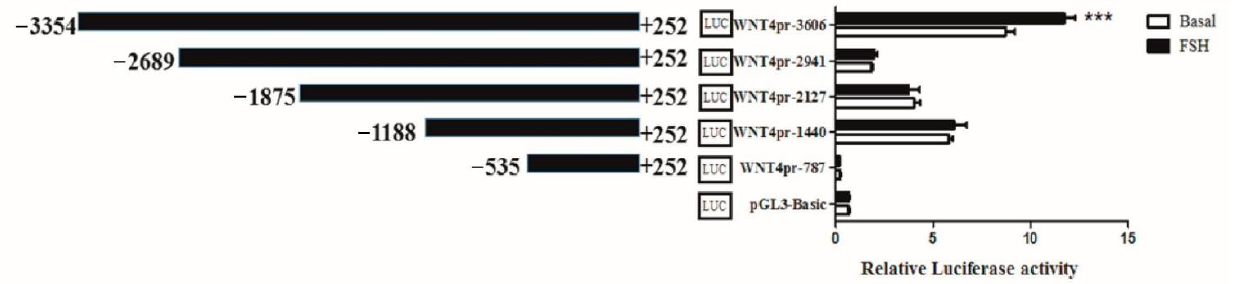
Figure 1. Luciferase assay of the effects of FSH on WNT4 promoter activity in chicken GCs. The numbering refers to the transcription initiation site, designated as +1. Each bar represents the means ± SEM. *** indicates p ≤ 0.001.